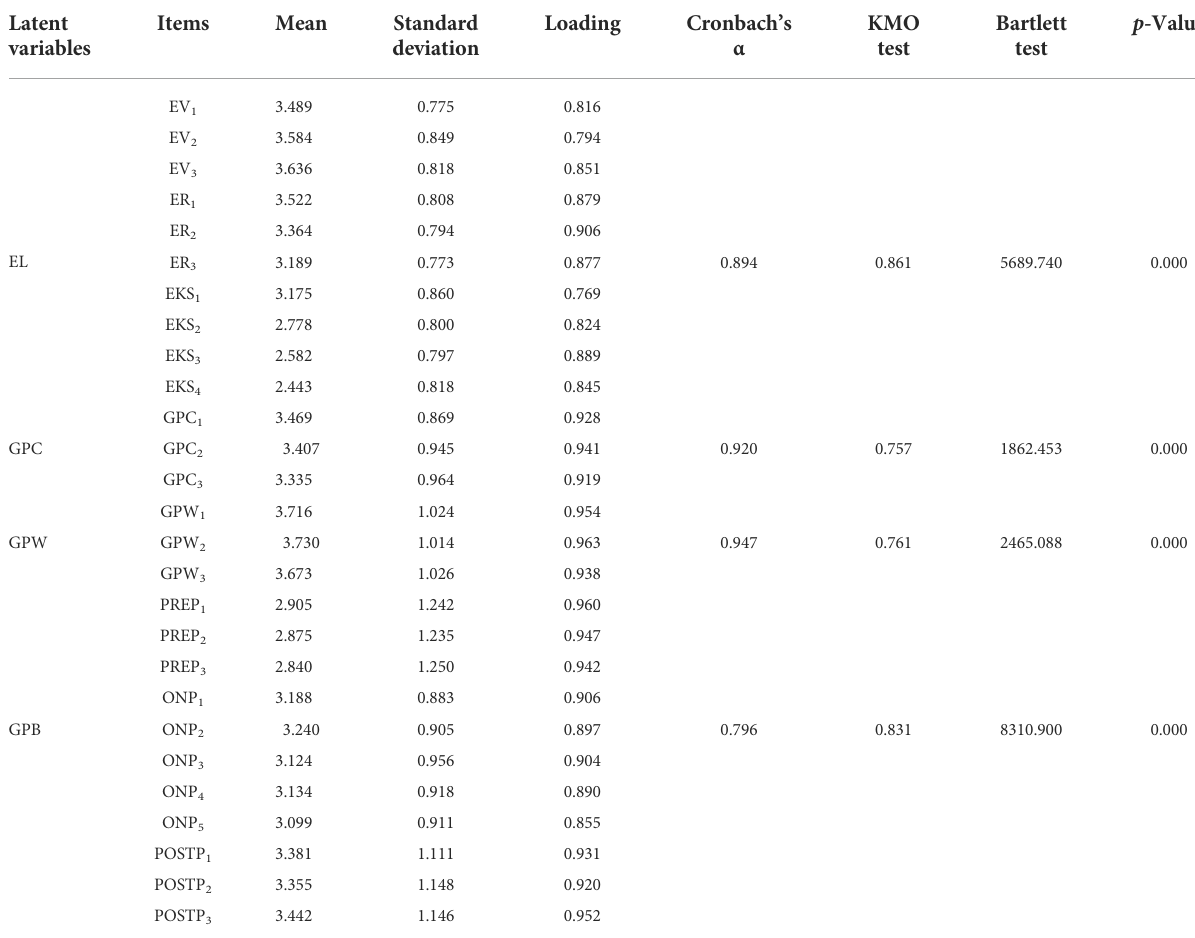
TABLE 3 Results of the reliability and validity test ( n =